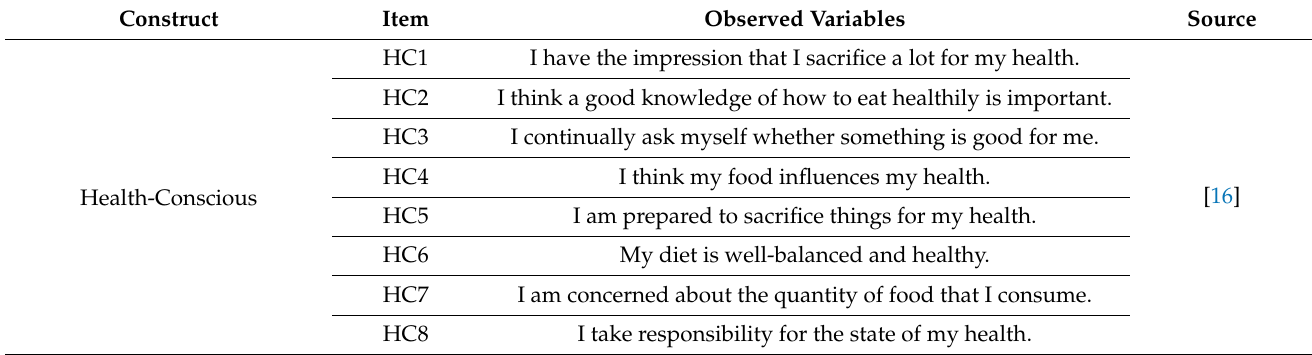
Table 2. Details of the health-conscious